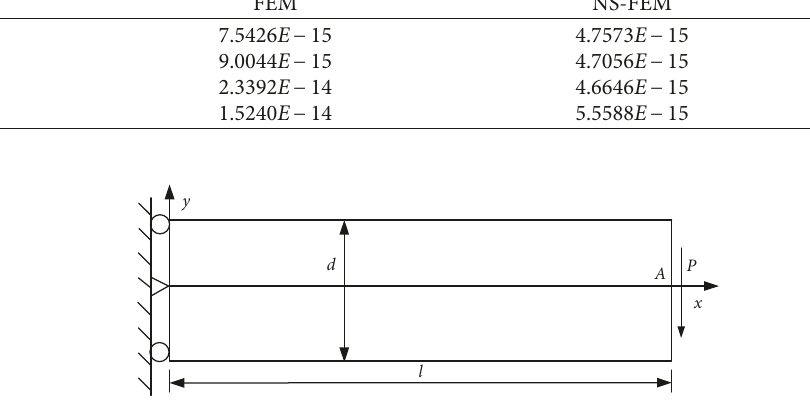
Figure 3: Cantilever beam